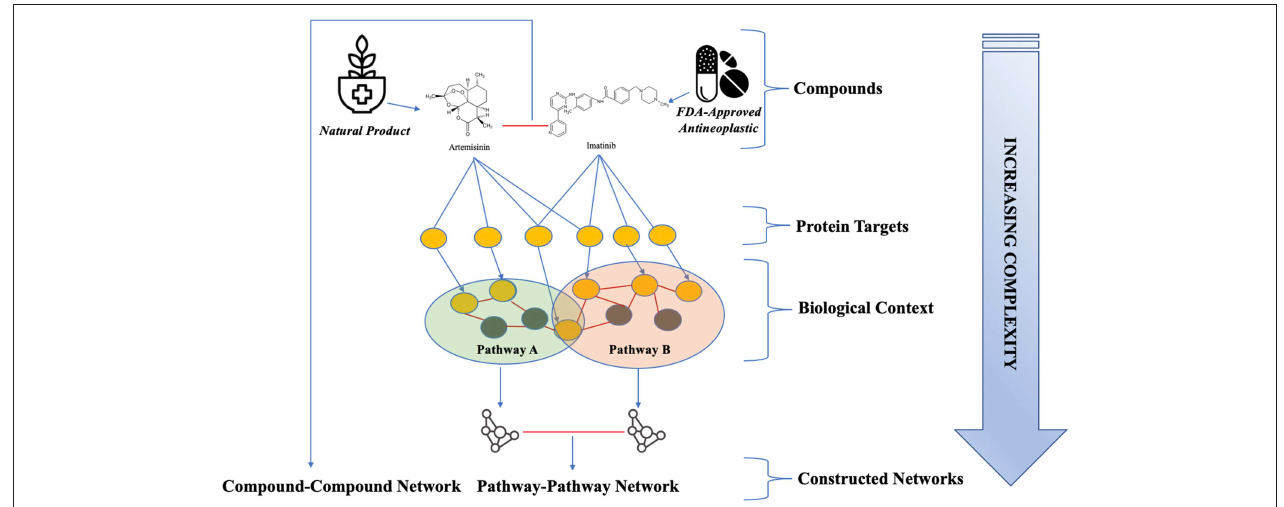
FIGURE 1 | Framework for natural product target network evaluation. The targets associated with both NPs and anti-neoplastic drugs were evaluated in different contexts of increasing complexity. Complementary and distinct coverage of protein targets and pathways by the two compound classes were assessed. Target importance and relationships were evaluated in biological contexts, which include protein-protein interaction networks and molecular pathways. Pathway relationships and shared target space were assessed through the construction of a pathway-pathway network and a compound-compound network. Red lines indicate the existence of an edge between nodes in these networks. Two compounds have an edge if they share at least one target, and two pathways have an edge if they share at least one protein ( Mahira and Umehara, 2018; Mykhal, 2004; Hinemash6,